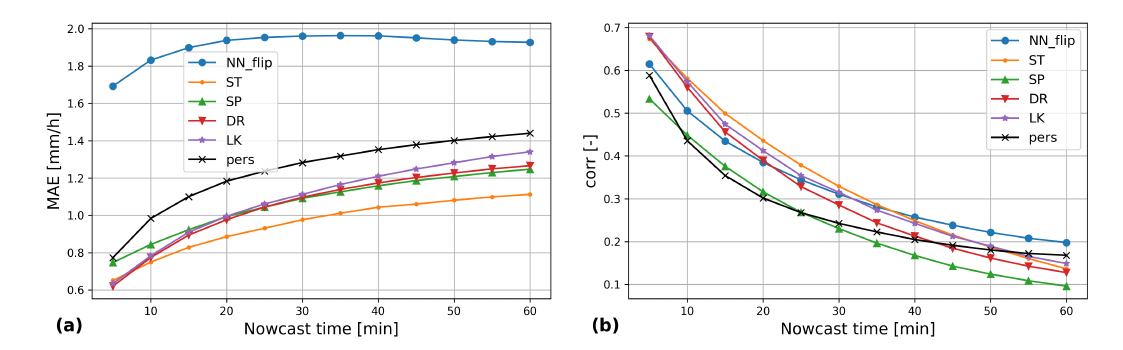
Figure 9. As in Figure 7. On box ( a ) the MAE and on box ( b ) the correlation coefficient of Pearson r as a function of the forecast time from 1 to 60 min, this time for the nowcast obtained by inverting the axes of longitude and latitude of the domain. The results for NN, the only ones that differ from those shown in Figure 7, are indicated with